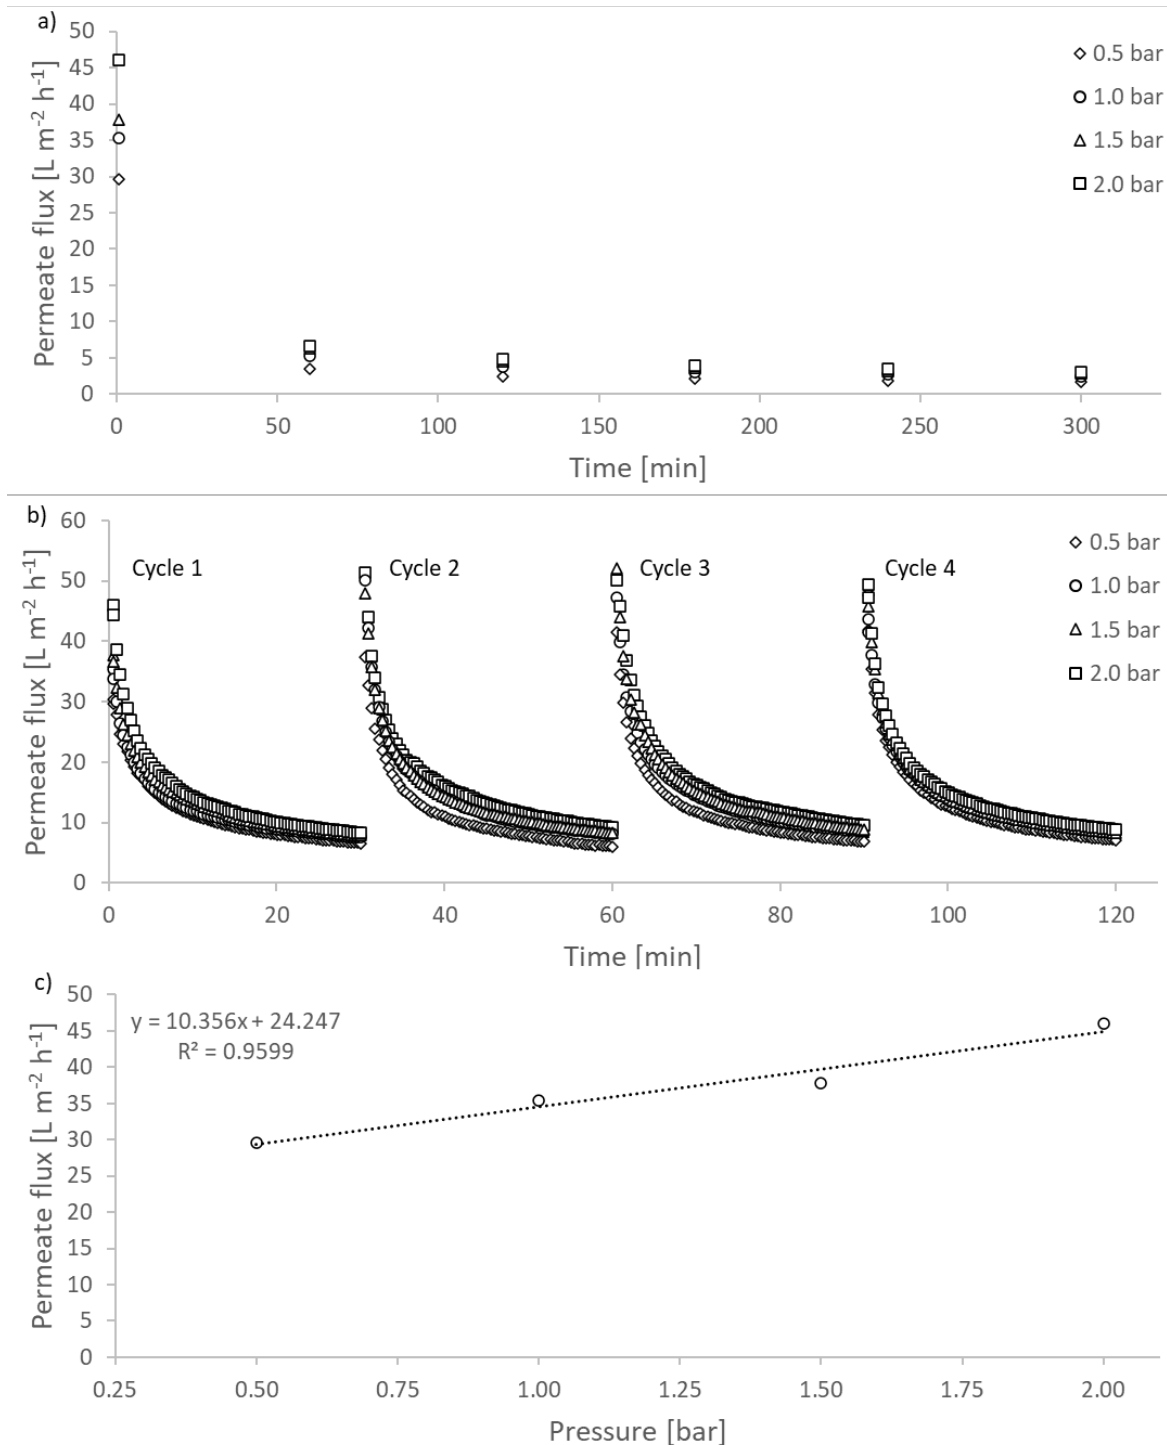
Figure 4. Permeate flux data for the frontal (dead-end) filtration experiments with digestate, no stirring, and a water wash following each experiment. ( a ) Variation of permeate flux with diluted digestate as a function of time at four pressures/300-min experiment; ( b ) permeate flux for four filtration cycles (data truncated on time axis for ease of display)/60-min experiment; and ( c ) initial permeate flux versus applied pressure.